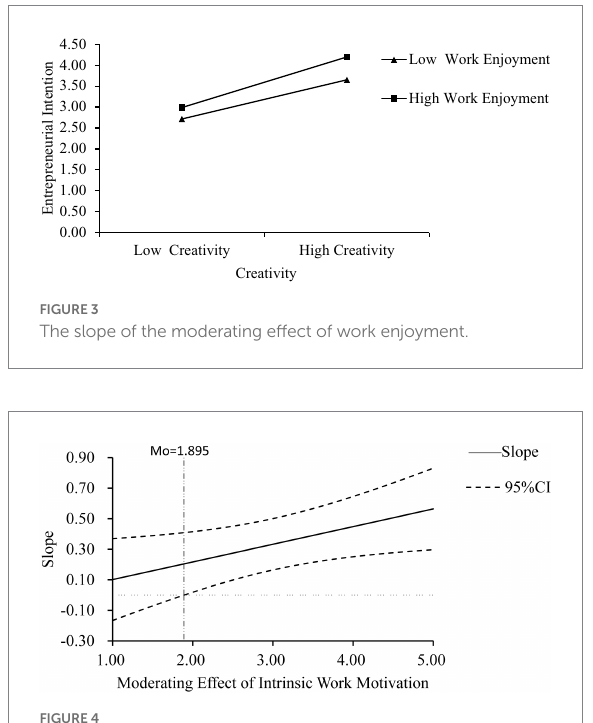
FIGURE 4 The moderating effect of intrinsic work motivation (Johnson– Neyman method).